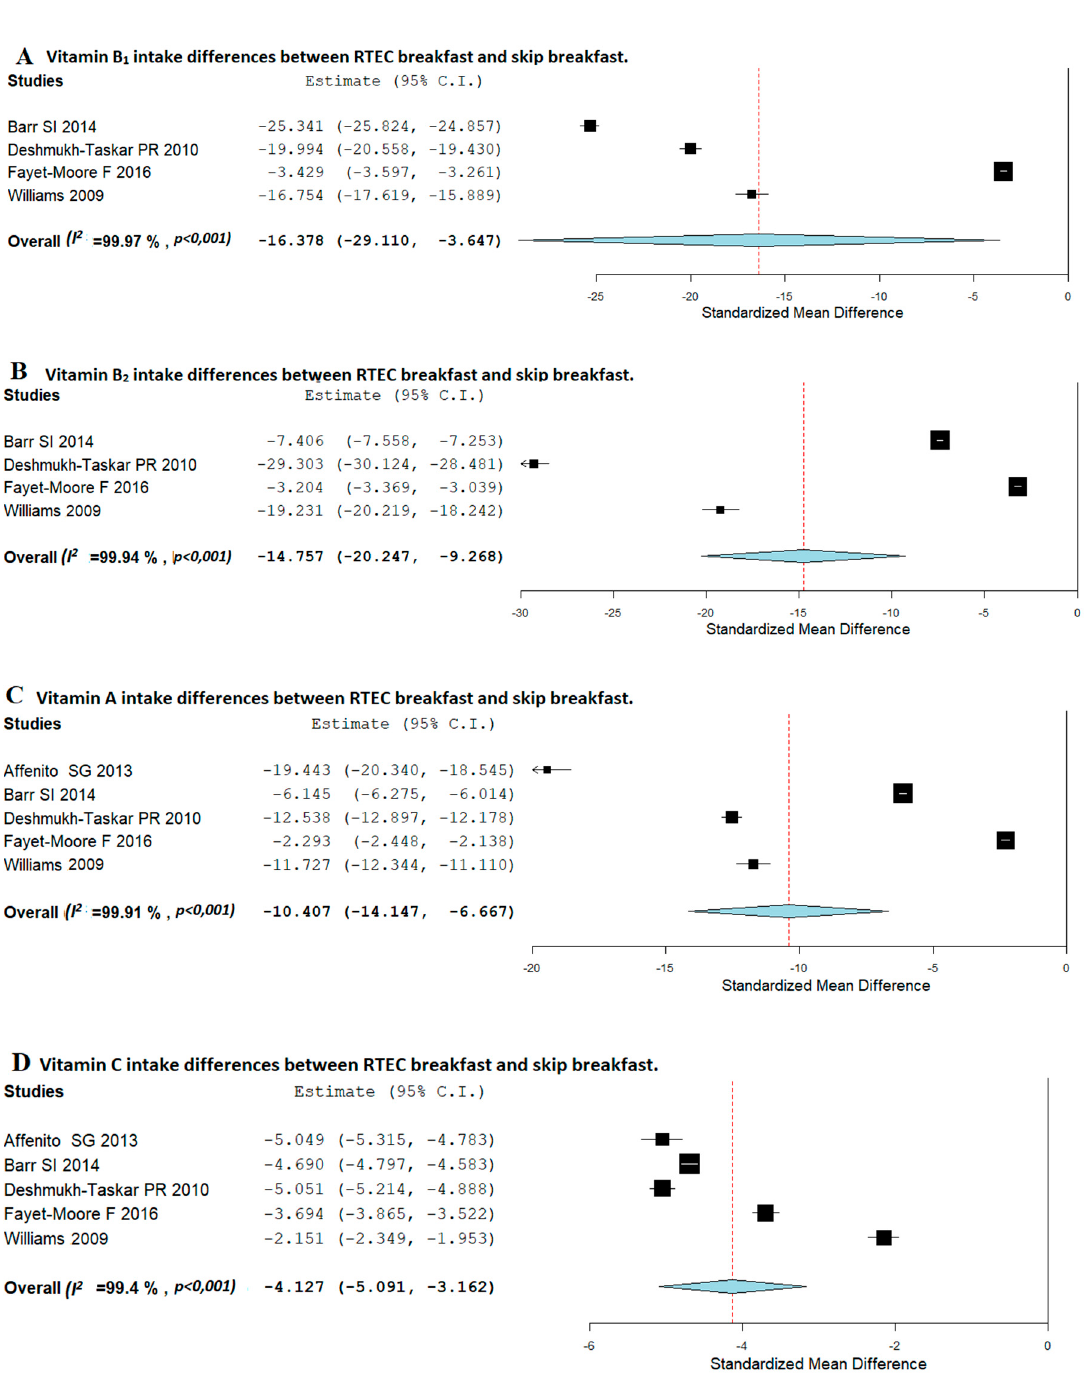
Figure 2. Random-effects meta-analysis of the effects of relationships between Ready to Eat Cereal (RTEC) breakfast and breakfast-skipping concerning vitamin B1 ( A ), vitamin B2 ( B ), vitamin A ( C ), and vitamin C ( D ) intake. CI: confidence intervals.